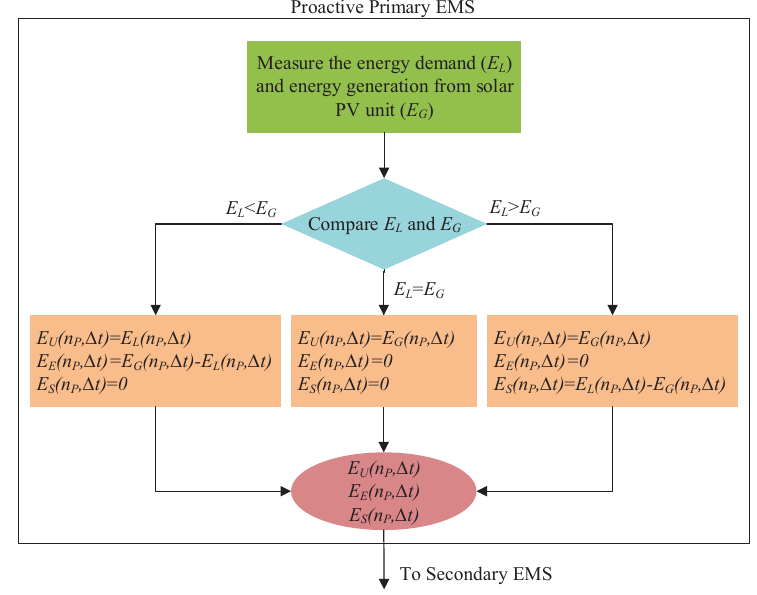
Figure 3. Energy information flow within a primary proactive EMS, as well as from the proactive to the secondary